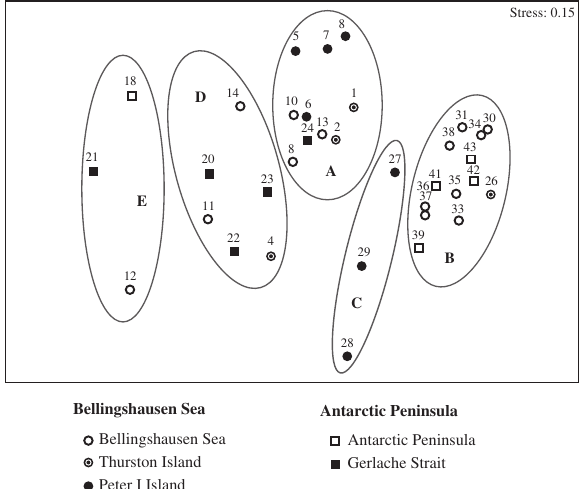
Fig. 3. – non-metric multidimensional scaling (mds) ordination plot of adjusted bray-Curtis similarities between bentart-03 and bentart-06